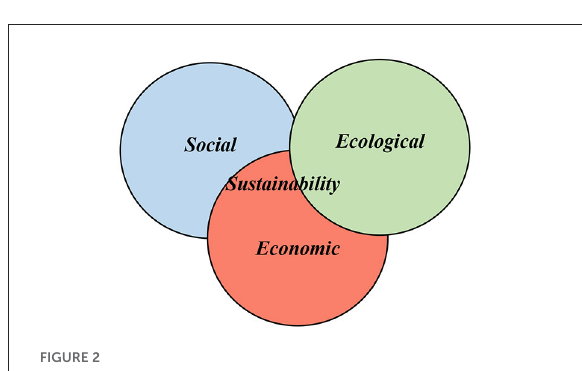
FIGURE2 The triple bottom